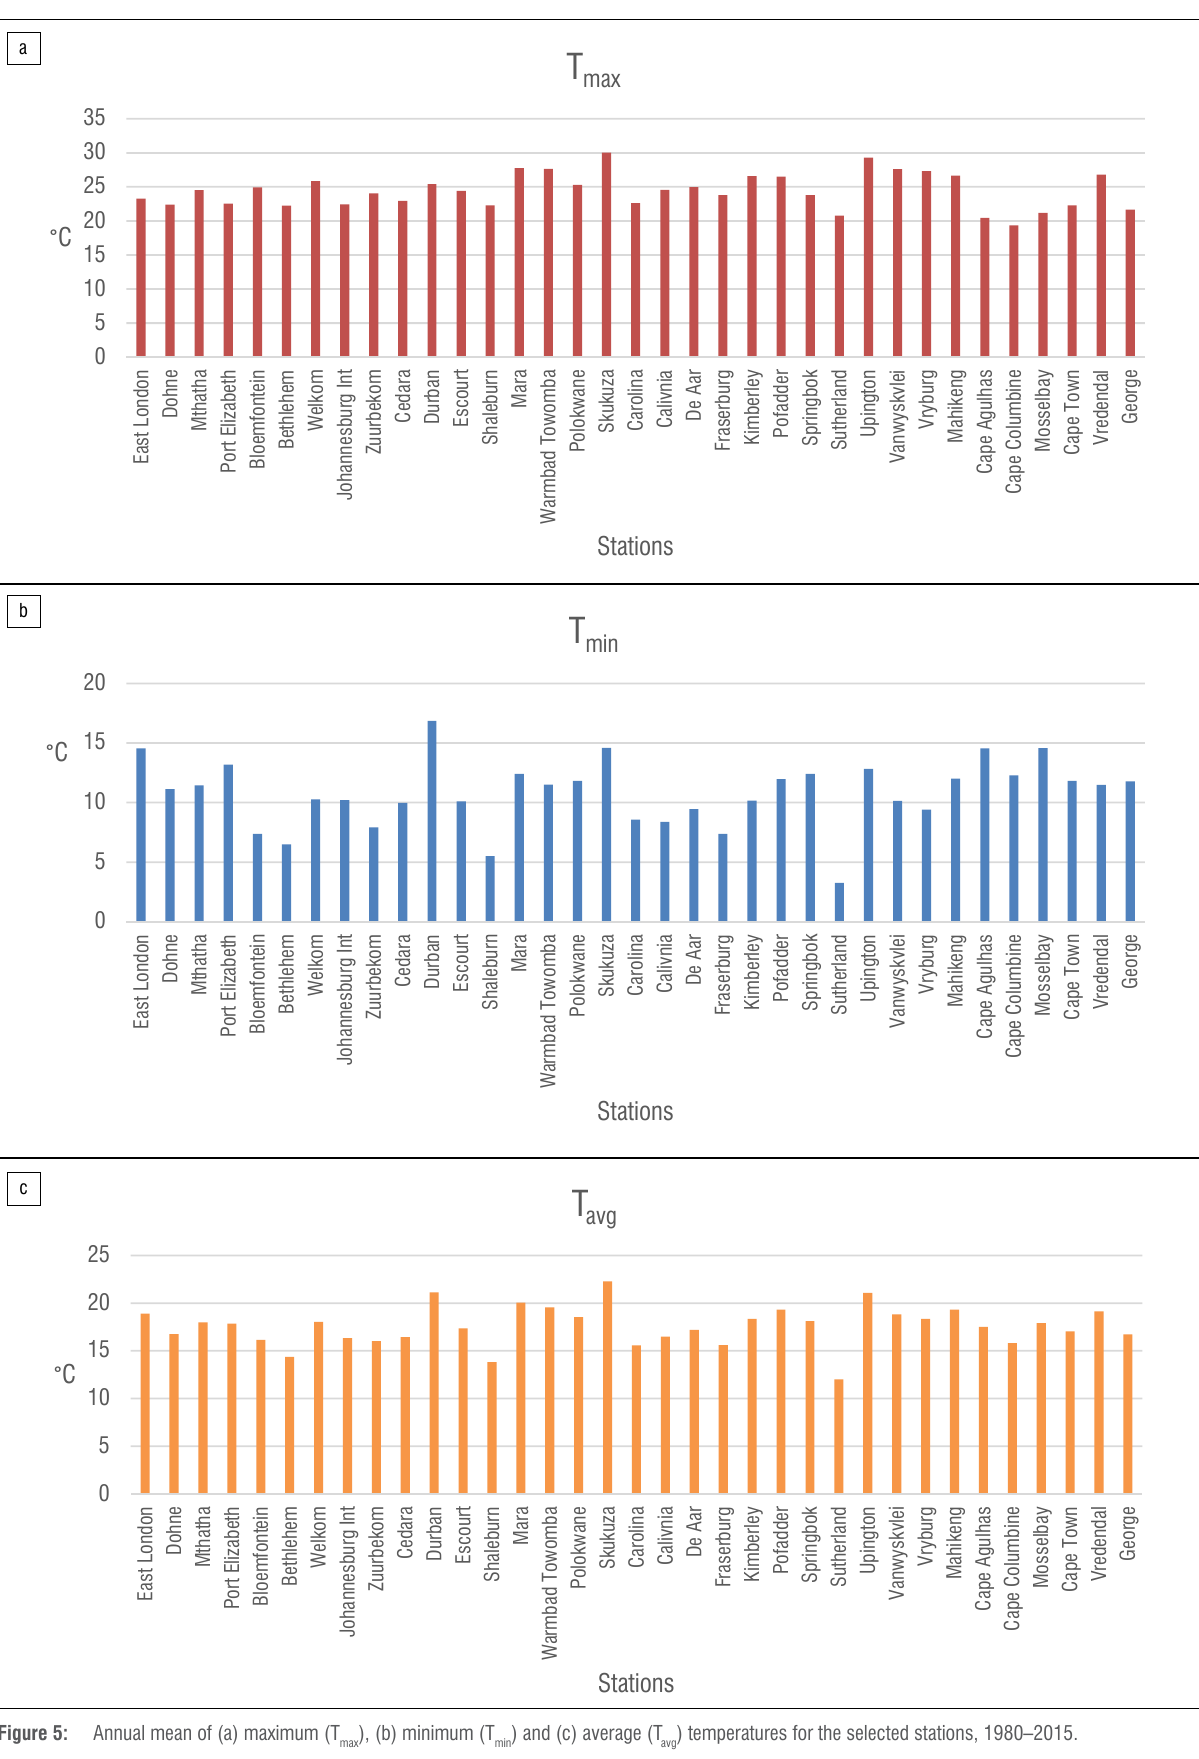
Figure 5: Annual mean of (a) maximum (T